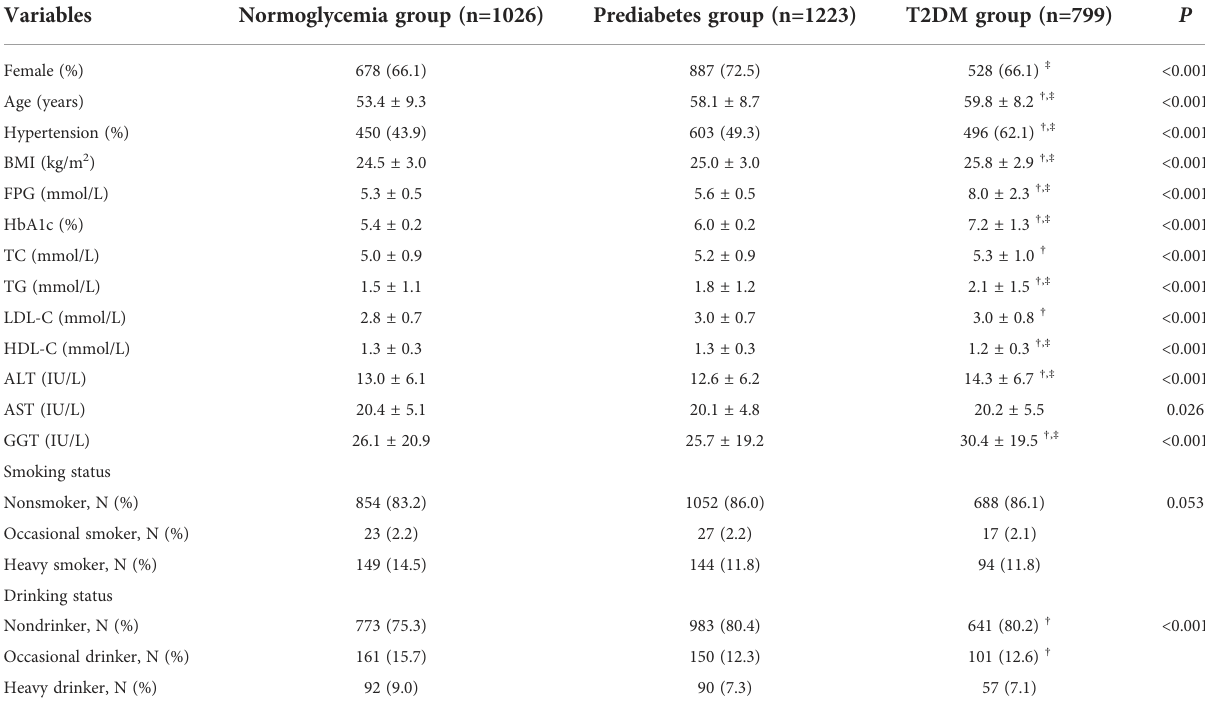
TABLE 1 Characteristics of the study population by categories of blood